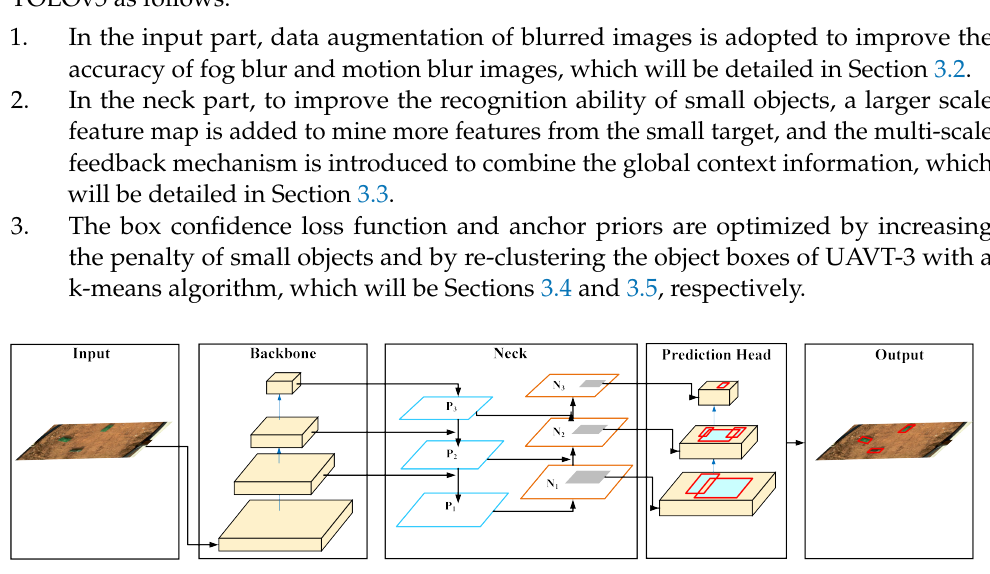
Figure 4. The Structure of